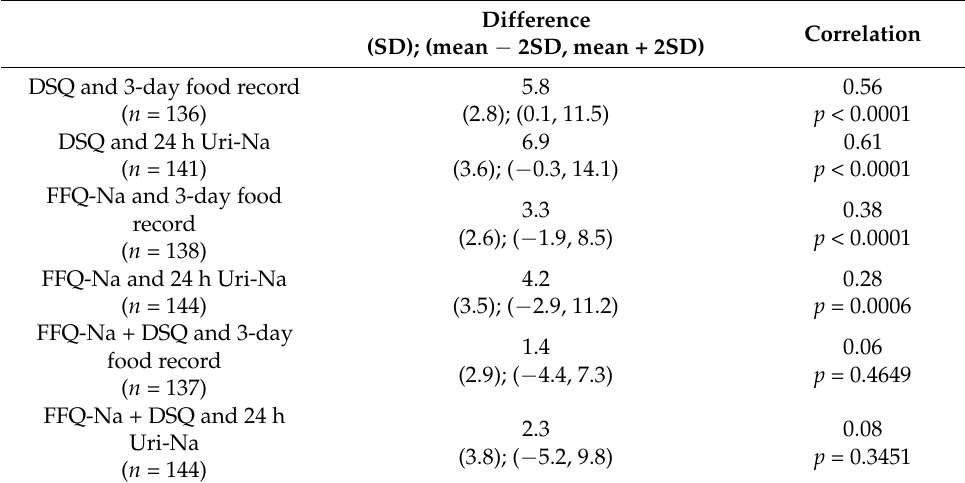
Table 5. Bland-Altman results for the DSQ, FFQ-Na, FFQ-Na + DSQ, 3-day food record and 24 h Uri-Na.